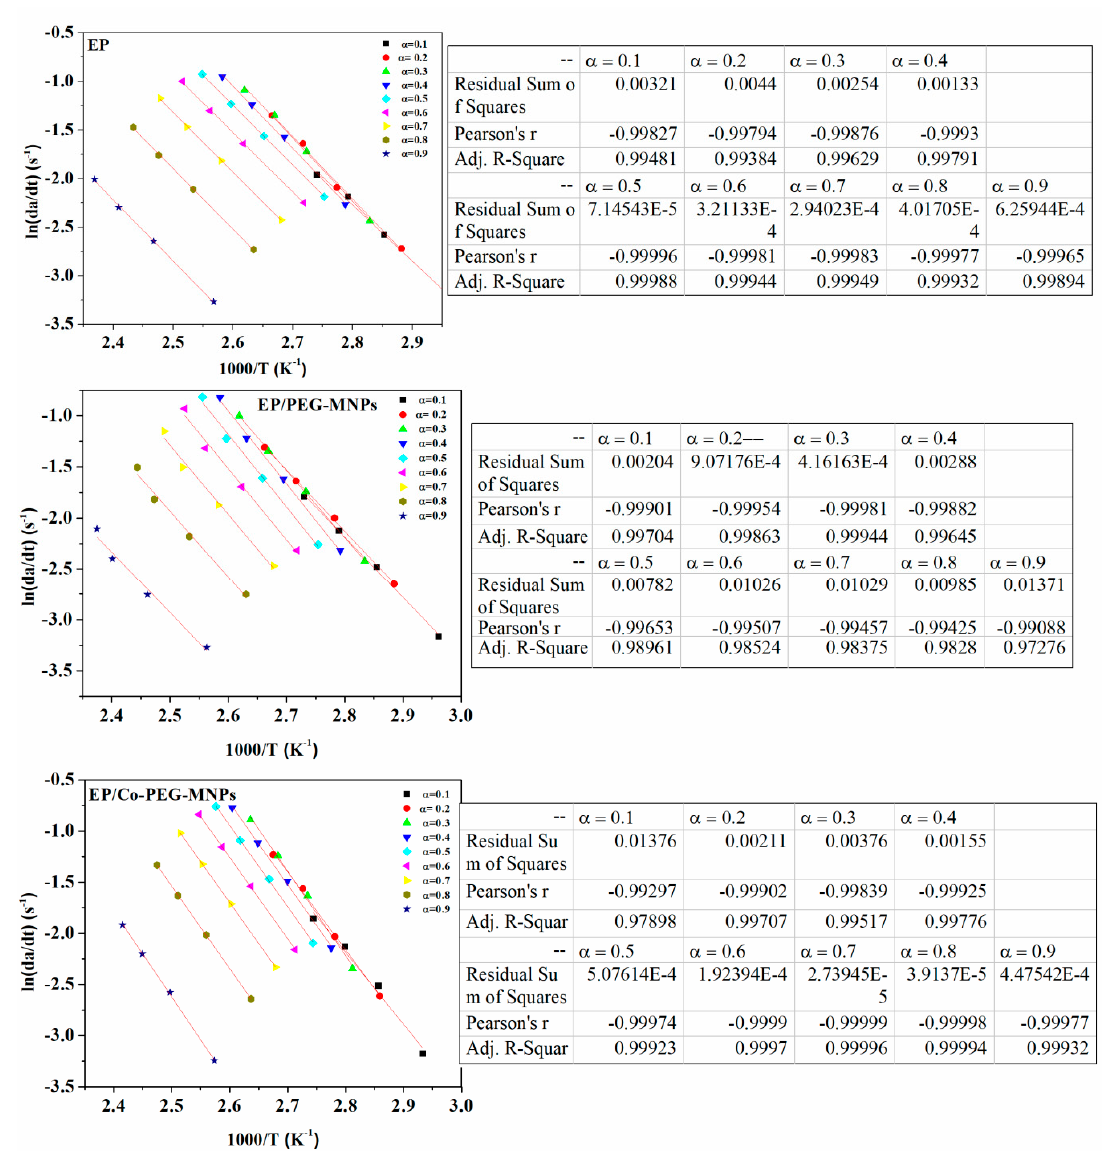
Figure A1. Arrays of ln ( d α / dt ) plots vs. 1 / T as typical plots obtained for the studied samples using Friedman model at β = 5 °C·min − 1 .